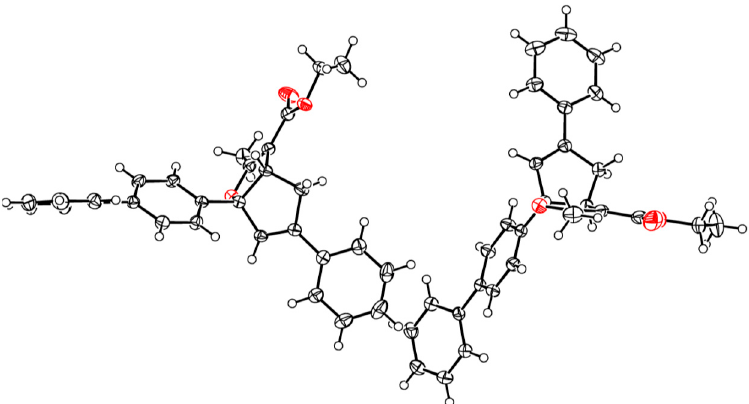
Figure 1. ORTEP plot of X-ray crystallographic data for 4b .